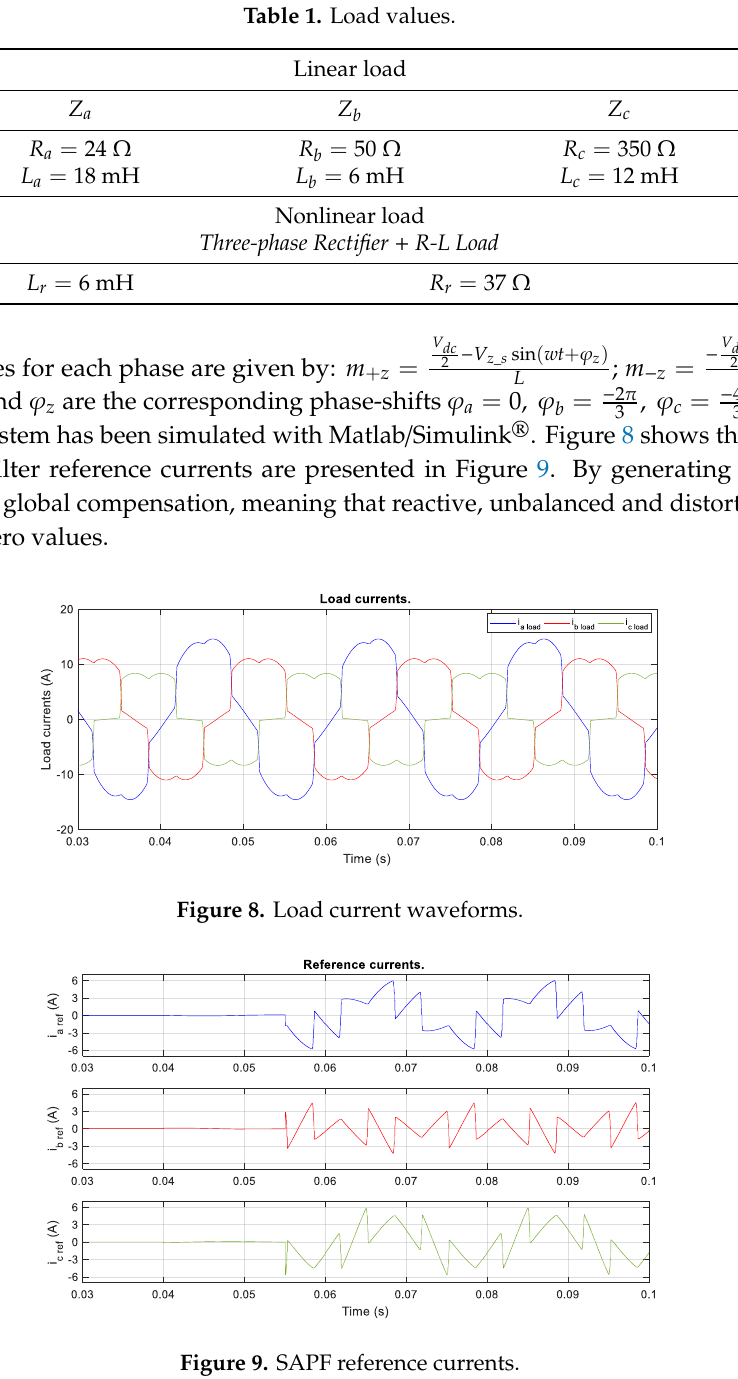
Figure 7. Block diagram of the power system under consideration.